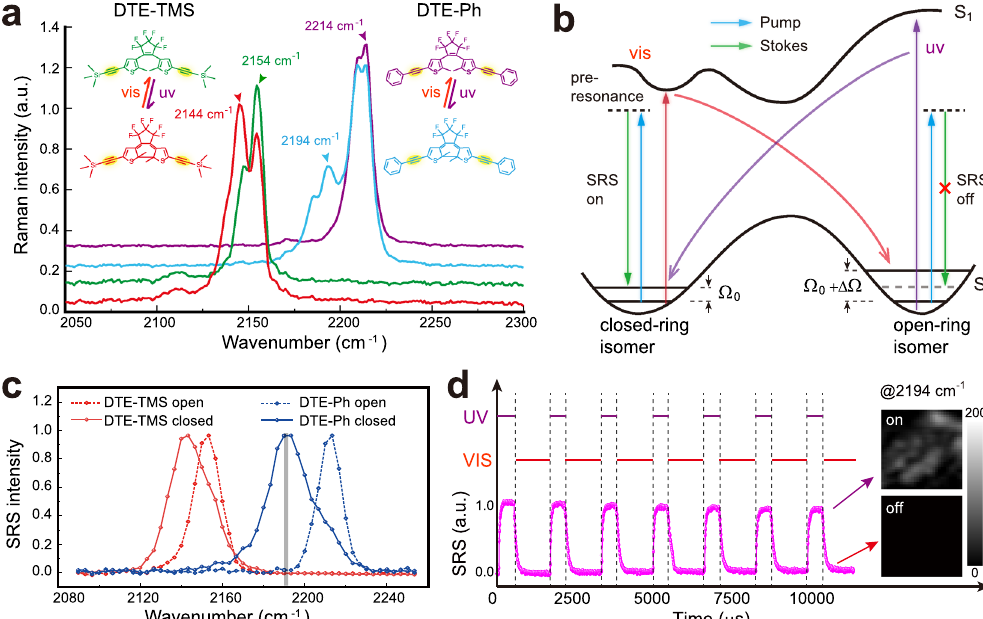
Fig. 1 Spontaneous and stimulated Raman response of the photoisomerization process of the DTE-alkyne derivatives. a UV (360 nm) induced photo- cyclization converts the open-ring isomers (green and purple) to the closed-ring structures (red and blue), resulting in spectral red-shifts of the alkyne spontaneous Raman peak (FWHM ~12 cm -1 ). Visible (633 nm) irradiation yields the reversed process of photo-cycloreversion with open-ring isomers and recovered Raman spectra (FWHM ~ 7 cm -1 ). Note that partial photo-cyclization under UV irradiation may results from the two-photon effect of the 1064 nm Raman pump. b Schematic diagram of the photoisomerization associated SRS switching with fi xed detection frequency ( Ω 0 ) of the closed-ring isomer. c SRS spectra of DTE-TMS and DTE-Ph in the open- and closed-ring forms. d SRS signal of DTE-Ph acquired at the UV-induced Raman frequency (2194 cm -1 ) shows on/off switching behavior under UV/visible pulsed